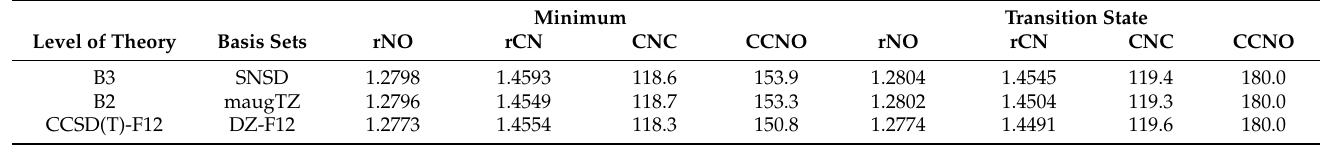
Table 1. Geometrical parameters of the dimethylnitroxide template molecule at different levels of theory. Minimum Basis